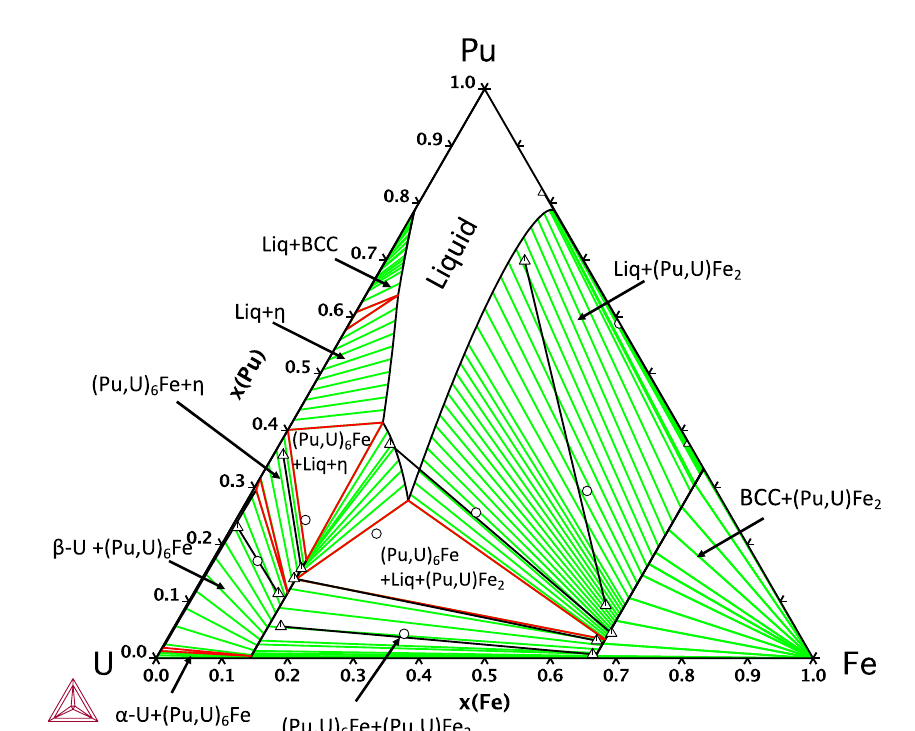
Figure 5. Calculated Pu-U-Fe phase diagram at 650 °C based on the present CALPHAD assessment compared to experiment [75].